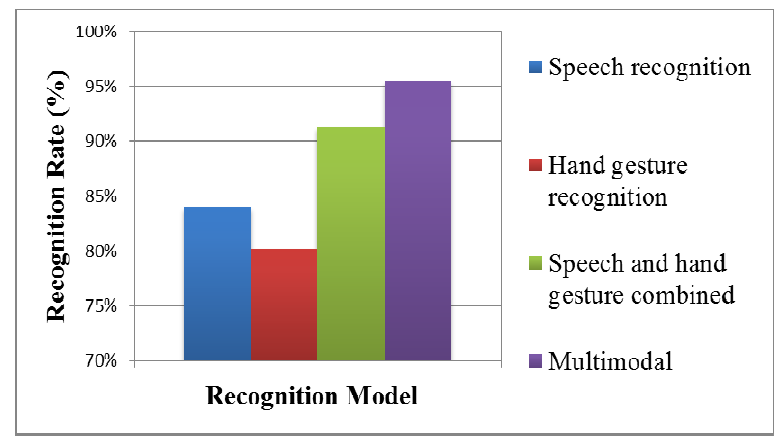
Figure 27. The correct recognition rate of the recognition